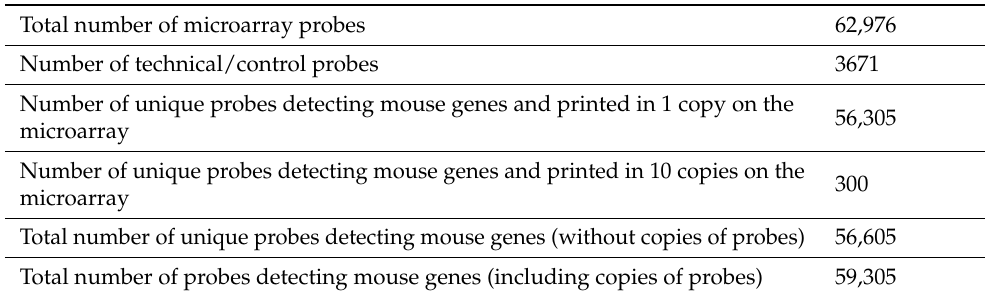
Table 1. The characteristics of microarrays (SurePrint G3 Mouse Gene Expression v2 8 × 60 K Microarray, 8 × 60